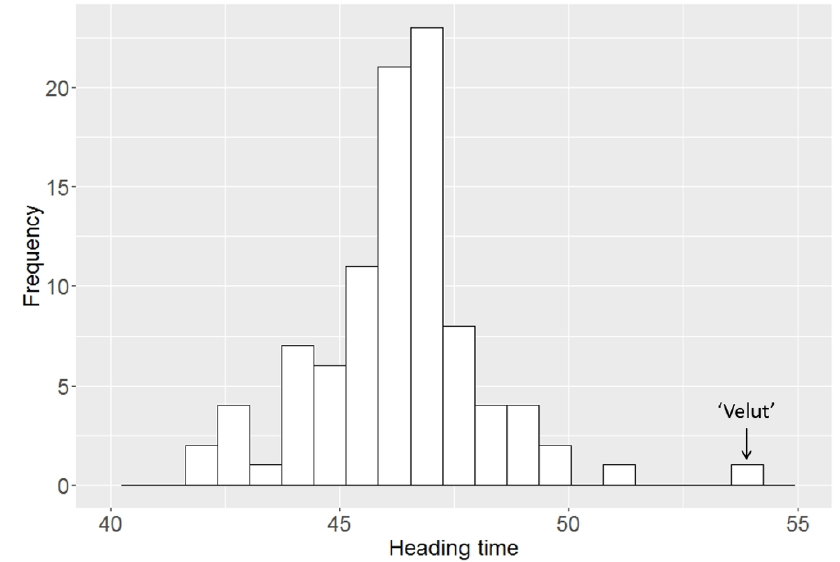
Figure 4. Mean heading times in the studied wheat varieties in 2016 and